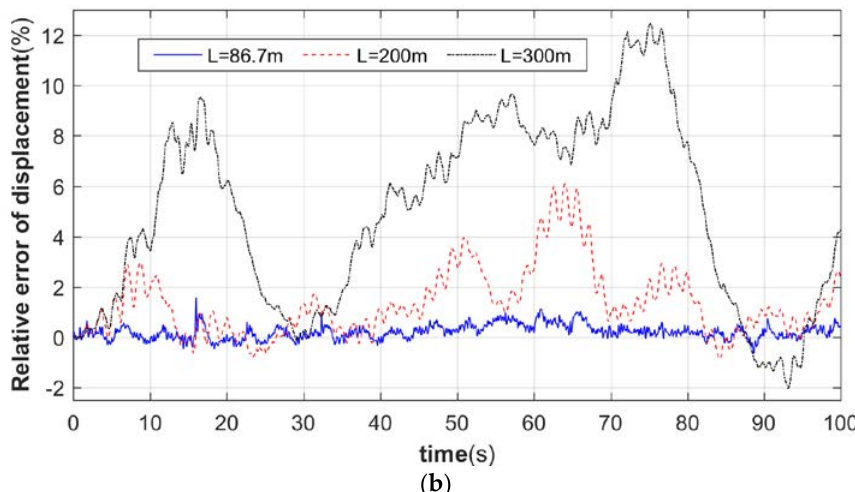
Figure 9. Relative error of tower top angle. ( a ) Pitch angle. ( b ) Lateral camber angle.